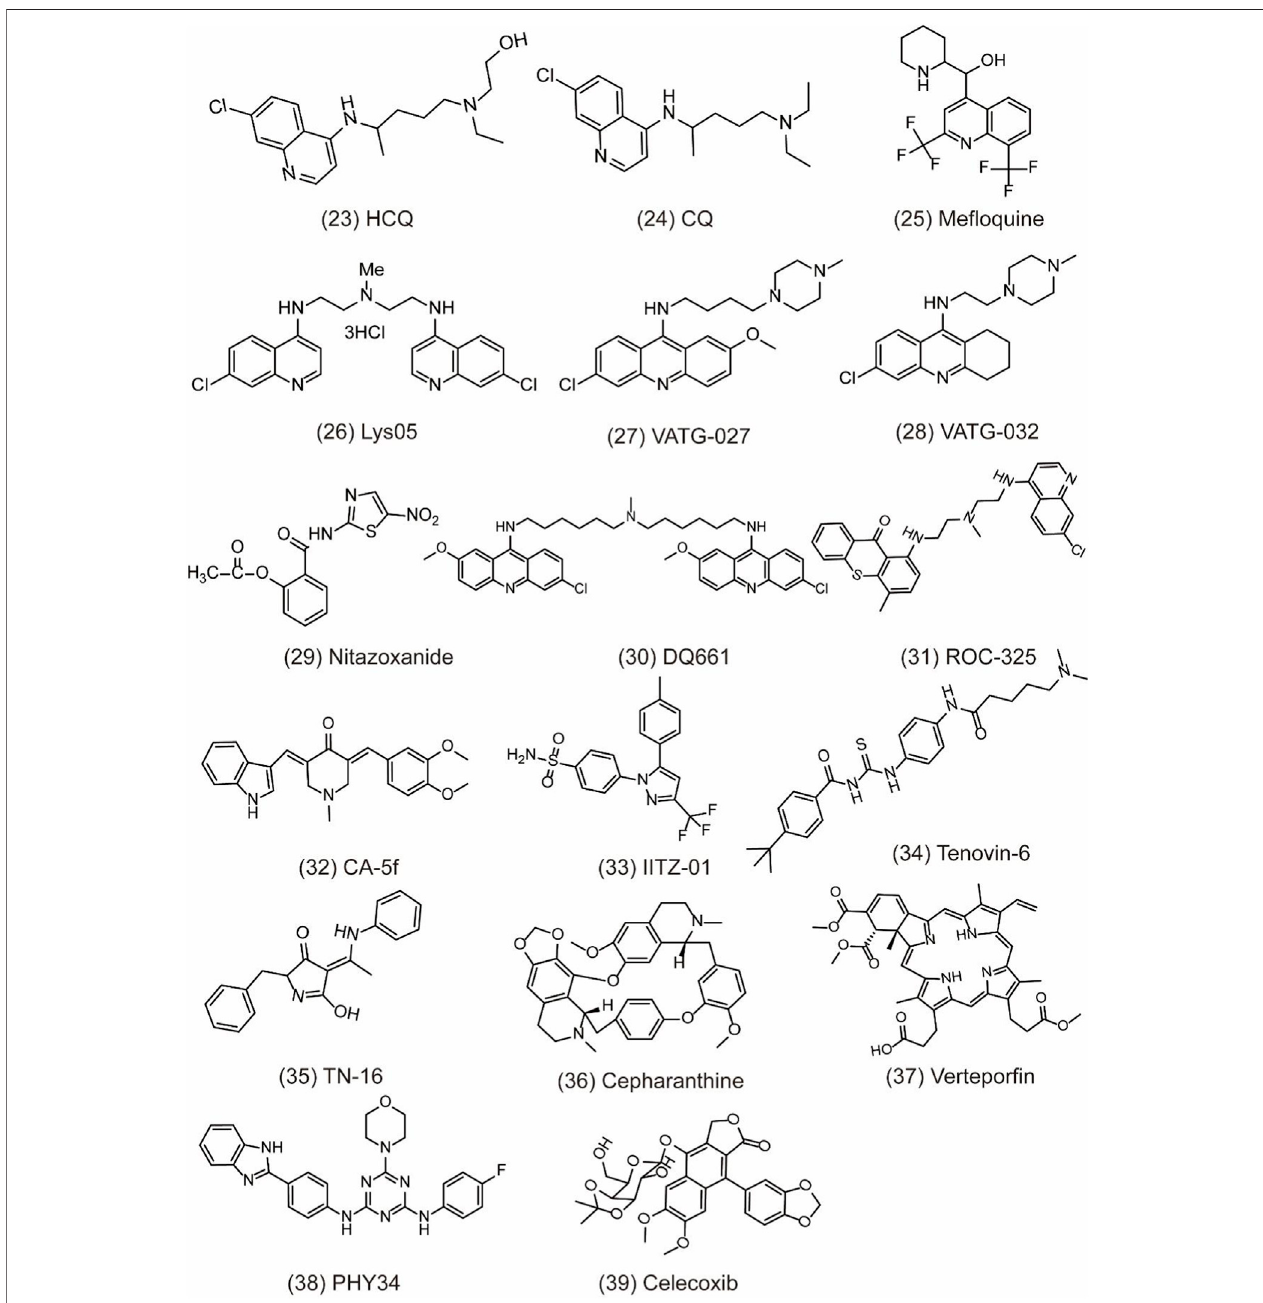
FIGURE 6 | Chemical structures of 23 – 39 as inhibitors of autophagy by targeting other targets.